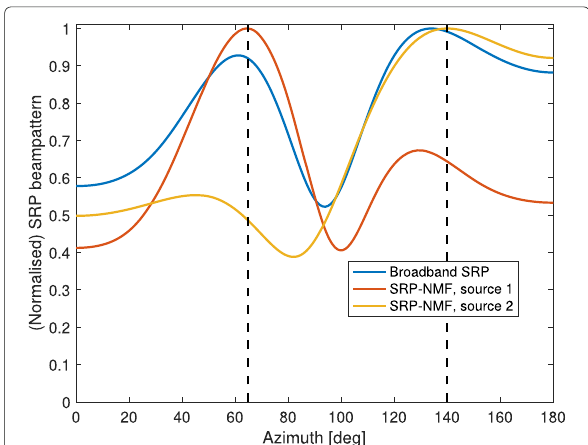
Fig. 2 Normalized SRP beampatterns of broadband SRP and SRP-NMF on a mixture of two sources. The dashed line indicates the ground truth of the source